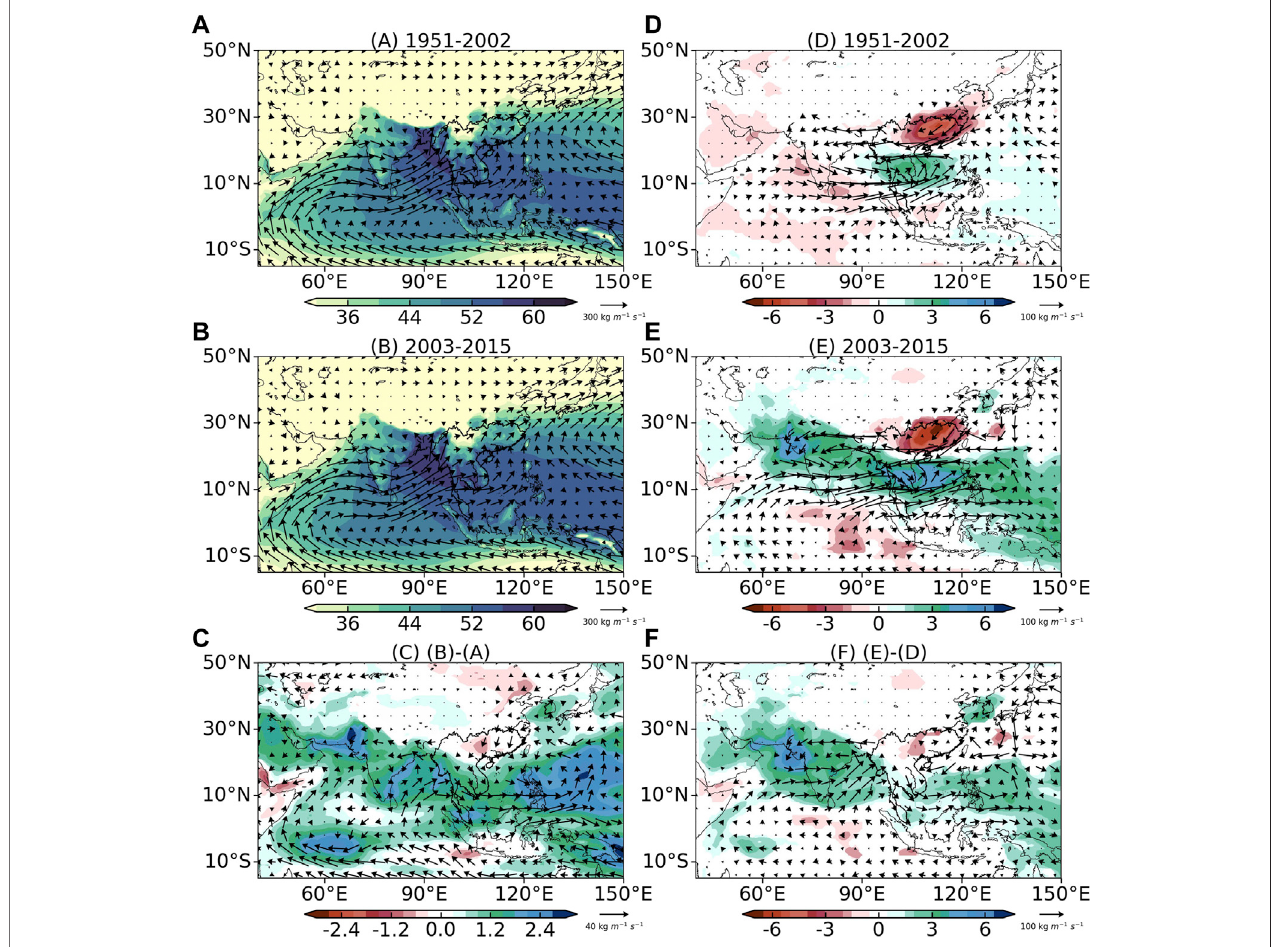
FIGURE 6 | Climatological mean total column water vapor (shading; units: kg m − 2 ) and vertically integrated water vapor fl ux (arrows; units: kg m − 1 s − 1 ) during